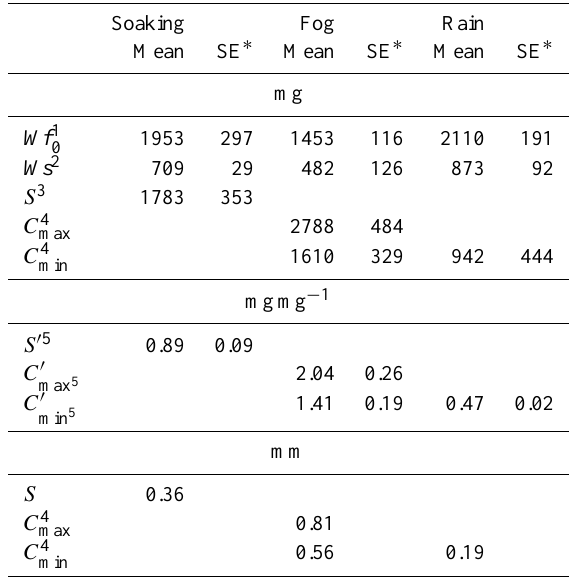
Table 1. Interception storage capacity of T. recurvata in laboratory conditions.